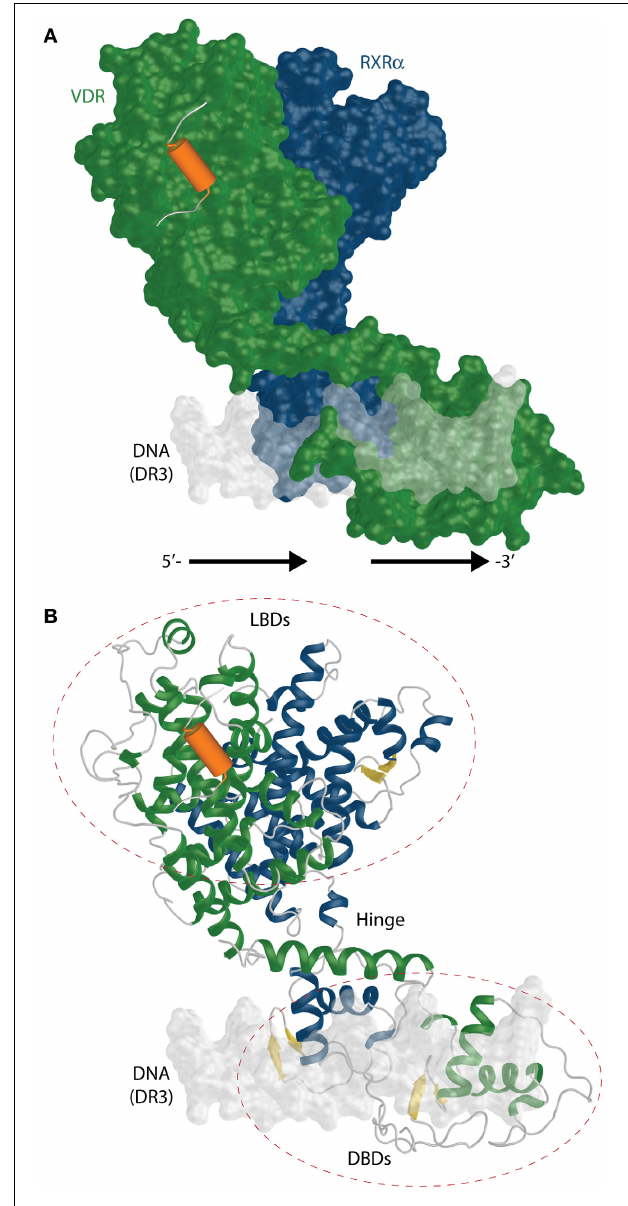
FIGURE 9 | The full length RXR-VDR structural model derived from SAXS and cryo-EM experiments. (A) A surface representation of the RXR(blue)-VDR(green) heterodimer is shown on DR3VDRE. The possible location of the coactivator peptide (orange) is highlighted as well. The 5 (cid:3) - and 3 (cid:3) -prime orientation of the DR3 is annotated. (B) Ribbon representation of the same complex shows the relative organization and fold of LBD, DBD and the connective hinge between them. The β -sheets are shown in yellow